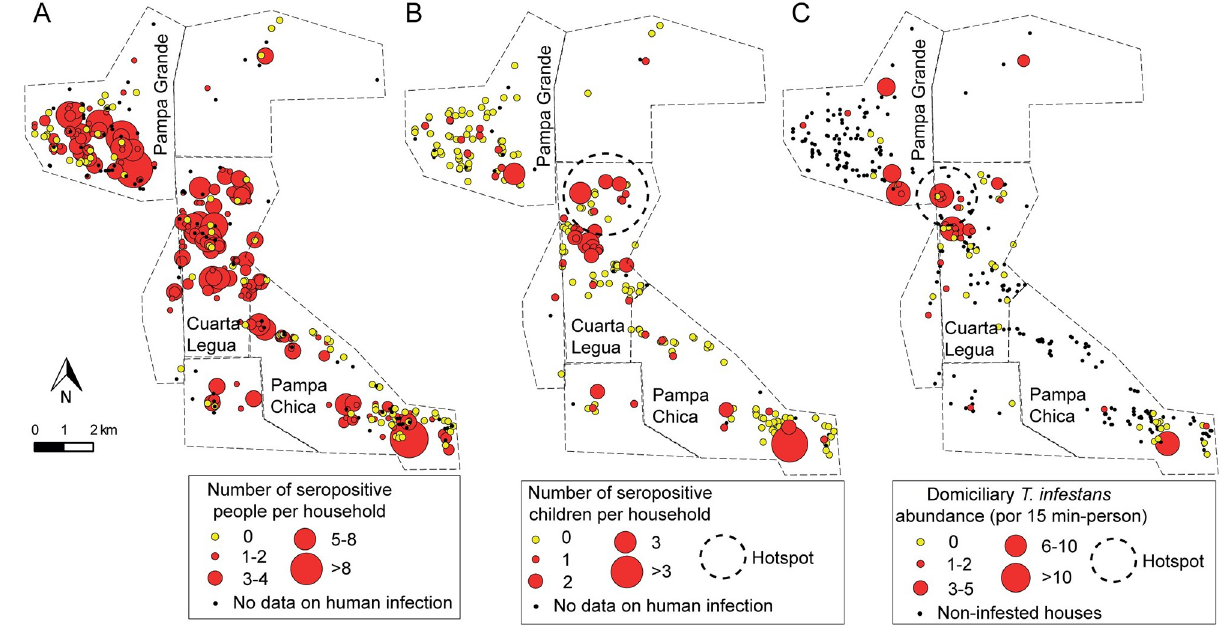
Fig 4. Distribution of the household number of T . cruzi -seropositive people (A) and children (B), and the relative abundance of infected T . infestans per unit of effort (C) prior to community-wide insecticide spraying in 2008, Pampa del Indio, Argentina. The dashed circles represent the hotspot found by local spatial analysis. The maps were created in QGIS 2.18.11. based on the data collected within the scope of this study (S4 Table).